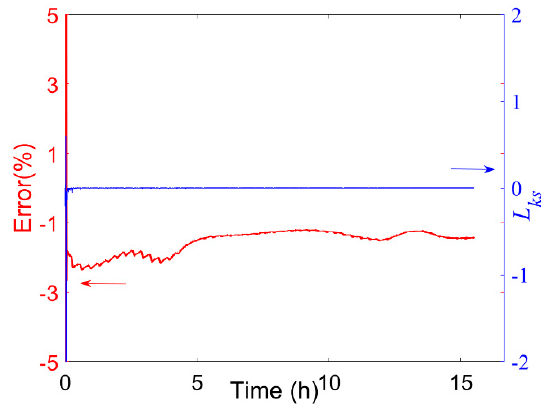
Figure 7. SOC estimation error and L ks (k) in the process of SOC estimation by AEKF: the red line represents the SOC estimation error and the blue line represents the SOC correction parameter L ks .